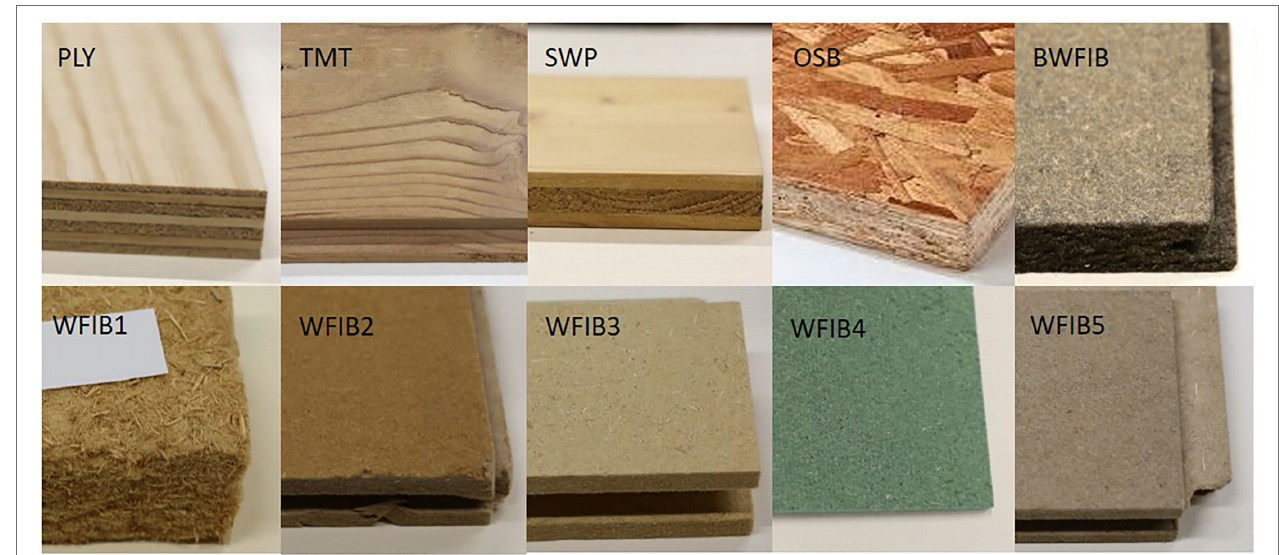
FIGURE 1 | Overview of selected wood-based building materials. Radiata pine plywood (PLY), thermally modified spruce (TMT), three-layer spruce panel (SWP), oriented strand board (OSB), bituminised wood fibre board (BWFIB) and wood fibre insulation type 1–5 (WFIB1-5).